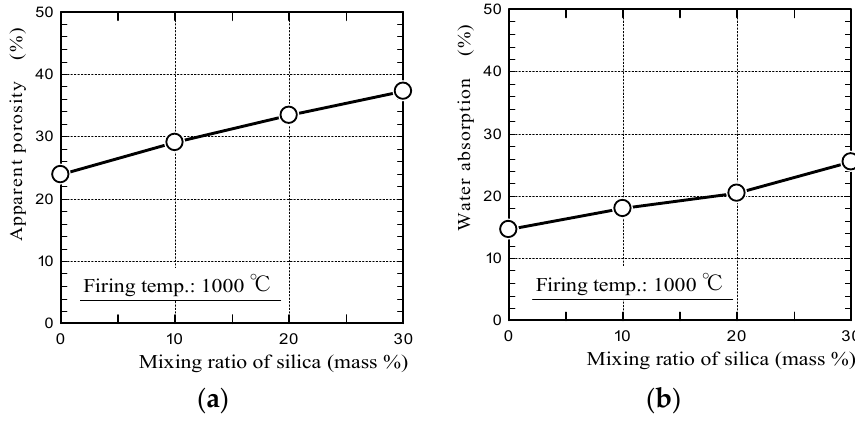
Figure 2. ( a ) Apparent porosities and ( b ) water absorption values of the ceramics.